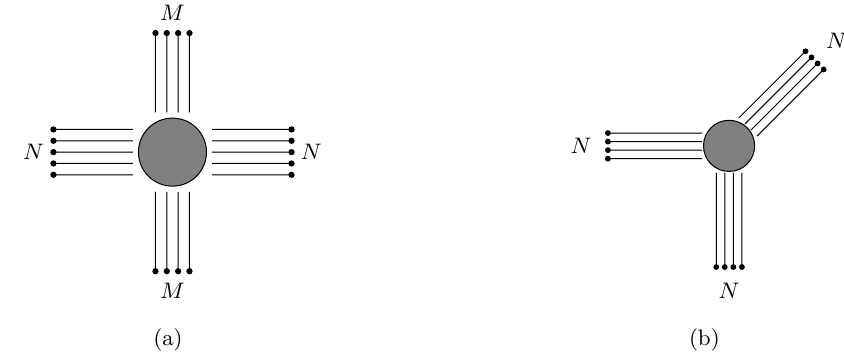
Figure 1 . 5-brane junctions: (a) # N;M theory and (b) unconstrained T N